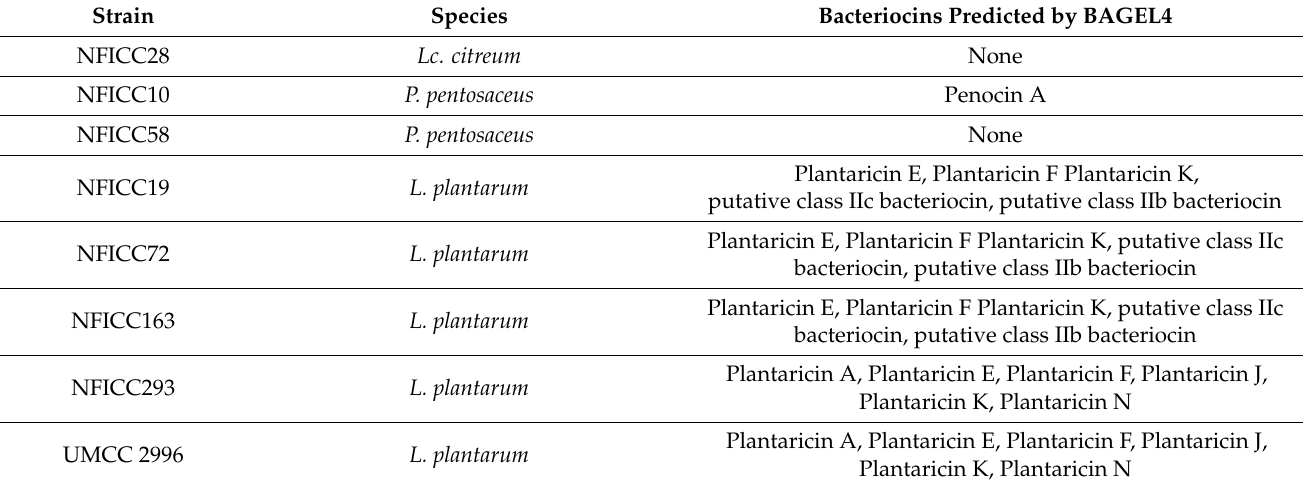
Table 7. Bacteriocins produced by the LAB strains displaying the highest inhibitory activity against ropy